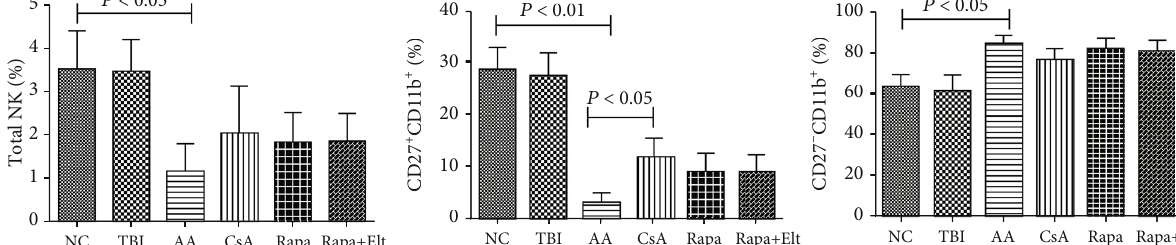
Figure 3: E ffi cacy of rapamycin combined with eltrombopag on numbers of NK cells. As for the CsA group, Rapa group, and Rapa+Elt